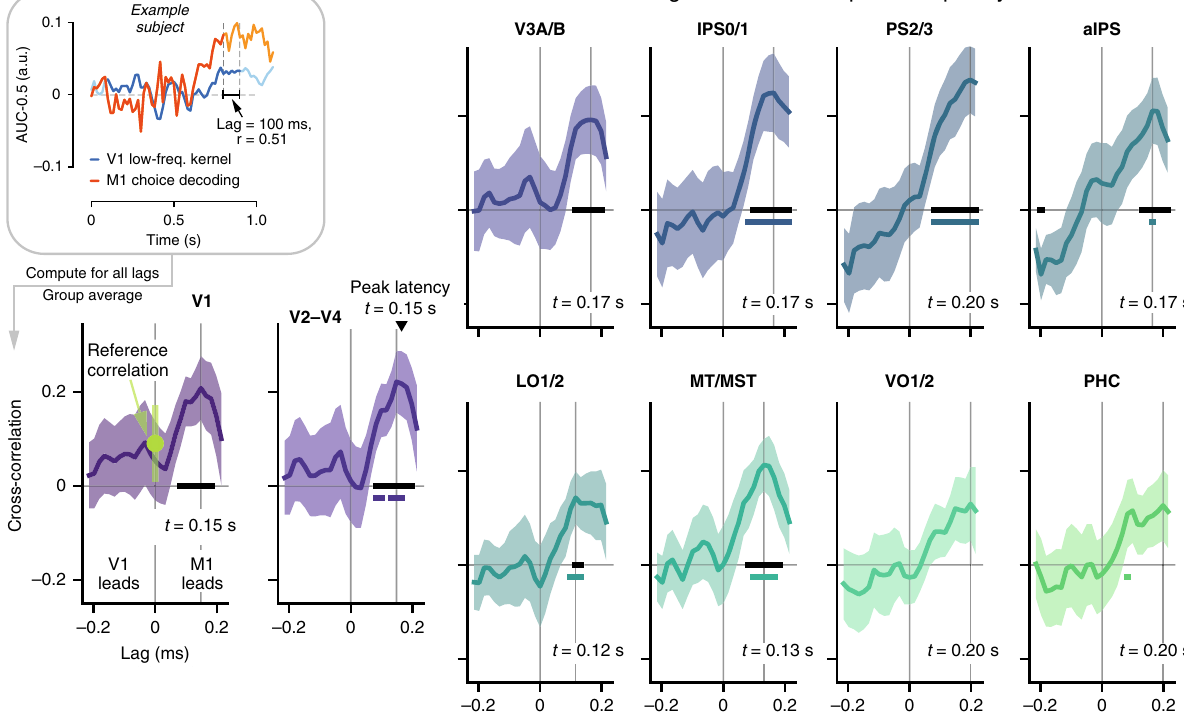
Fig. 5 Link between choice-predictive M1-activity and visual cortical low-frequency kernels. Cross-correlation between choice-predictive activity in M1- hand (Fig. 2c) and V1 low-frequency kernel, with the latter re-computed at the same temporal resolution as the former (Supplementary Fig. 10 and inset). Inset: Illustration of analysis approach for one example subject and lag. The cross-correlation function between V1 low-frequency kernel and choice- predictive M1 activity was evaluated for a range of lags from − 215 to 215 ms (positive lags indicate lead of M1), and collapsed across subjects. Reference correlation is correlation between choice-predictive activity and low-frequency kernel at lag t = 0, both taken from M1 (upper bound of signal leakage); it is shown in V1 plot (green) but was applied to evaluate correlations for all visual fi eld maps. Data are represented as mean ( n = 15 subjects, lines, reference correlation: green dot) and ±SEM (shaded areas, reference correlation: error bars). Horizontal bars, p < 0.05: black bars, against 0; colored bars, against reference correlation (all two-sided t -tests). Source data are provided as a Source Data fi